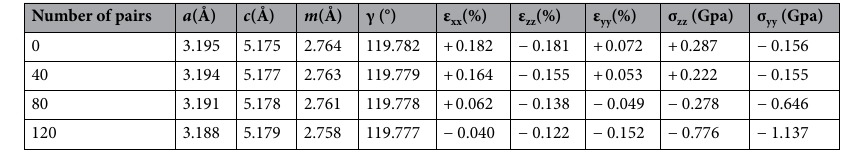
Table 3. Lattice parameters for grown GaN obtained from RSM scan along (11–22) plane. + tensile; − compressive.